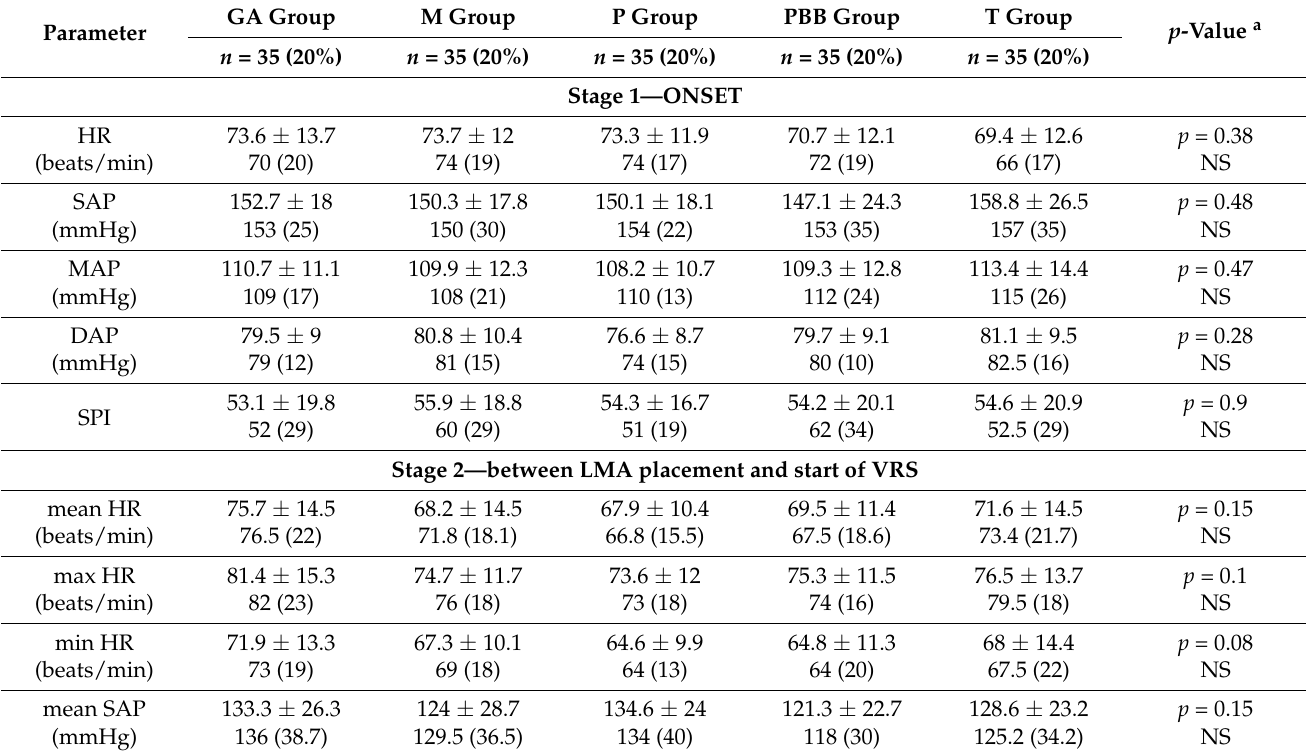
Table 4. Hemodynamic changes in patients with intraoperative pain perception during certain stages of